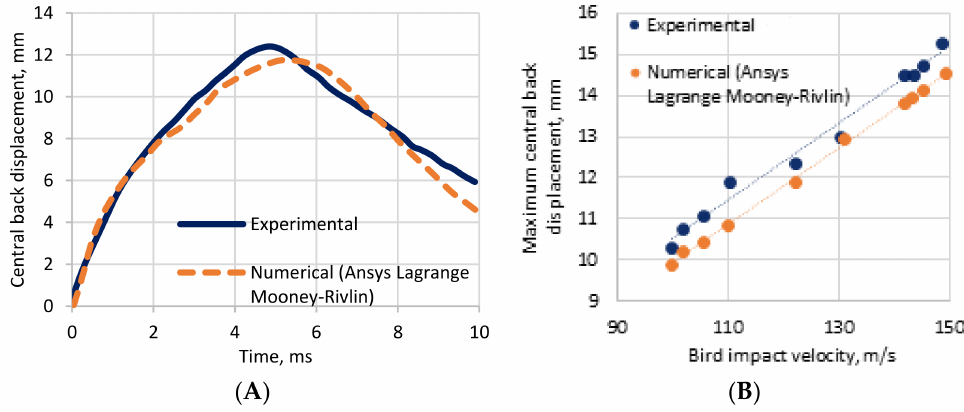
Figure 6. Post impact displacement data of experimental [38] and numerical outcomes. ( A ) Central back displacement at 122 m/s; ( B ) Maximum central back displacement at different impact